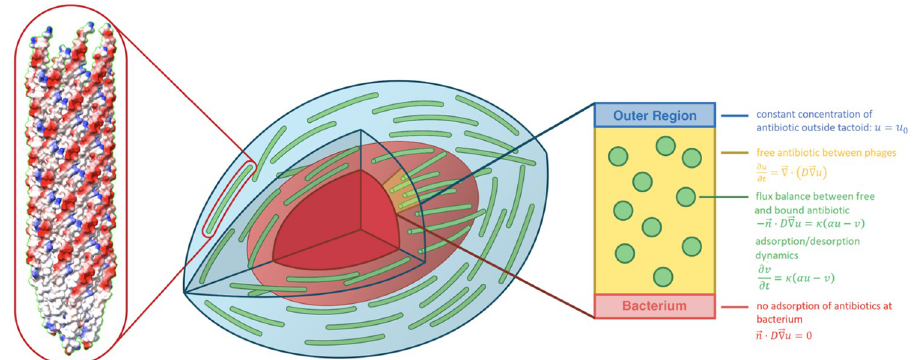
Fig 1. Schematic sketch of the tactoid model. The central image shows a schematic sketch of a tactoid (in blue), with phages (green) surrounding a bacterium (red). The structure of a phage is shown on the left, with colour indicating electric charge: red signifies negative charge, and blue positive. An example of a two-dimensional tactoid domain on which the model is solved is shaded in yellow. This domain is sketched on the right, with model equations and domain parameters